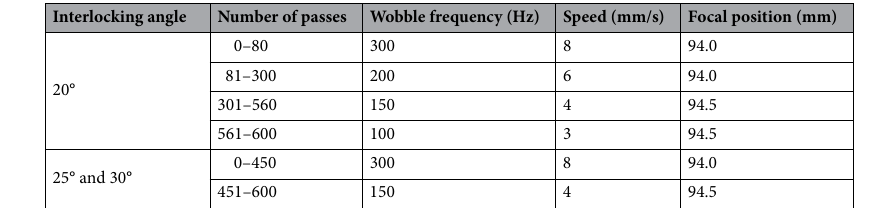
Table 2. Picosecond laser scheme to achieve deep cuts on alumina.